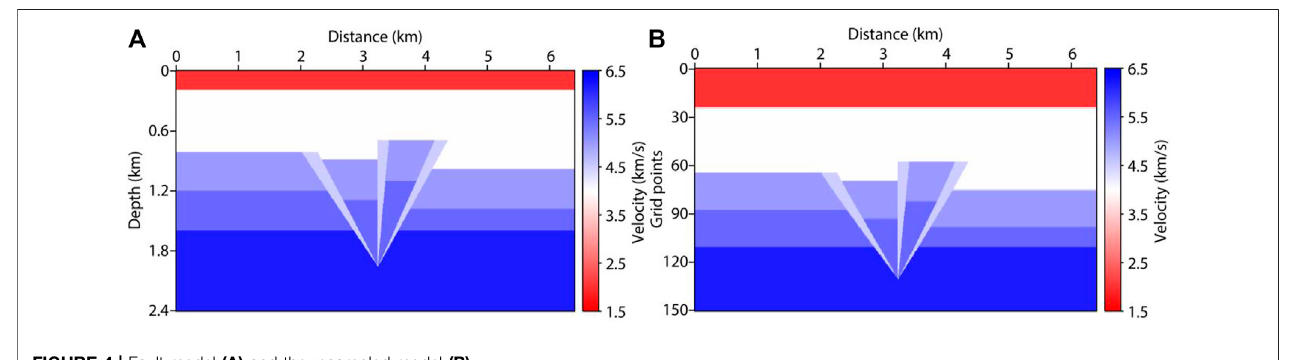
FIGURE 4 | Fault model (A) and the resampled model (B)